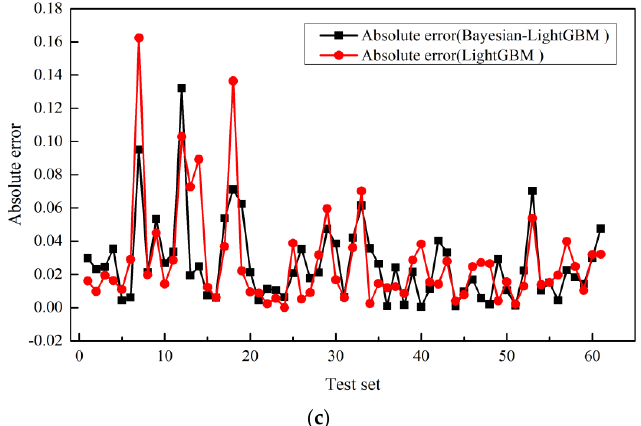
Figure 13. Prediction results of friction coefficient. ( a ) LightGBM model prediction results. ( b ) Bayesian-LightGBM model prediction results ( c ) Distribution chart of the absolute error between the observed value and the predicted value.